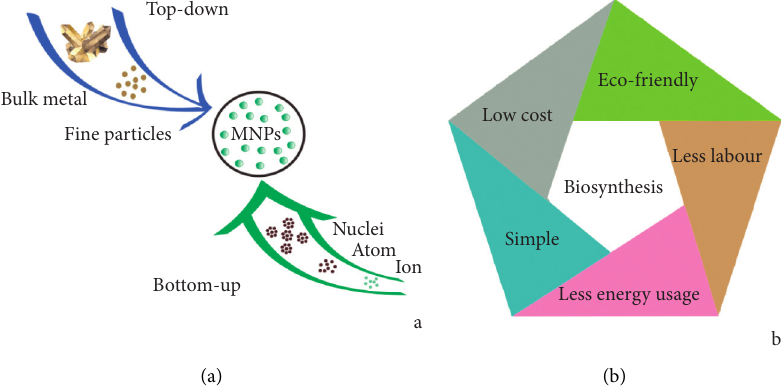
Figure 1: Two synthesis strategies of metal nanoparticles (a) and advantages of biosynthesis methods of MNPs